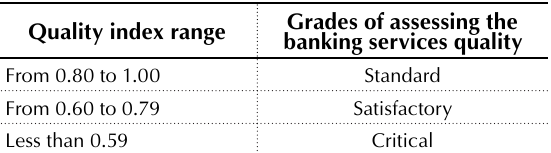
Table 2. Evaluation of banking services quality compliance with the requirements of